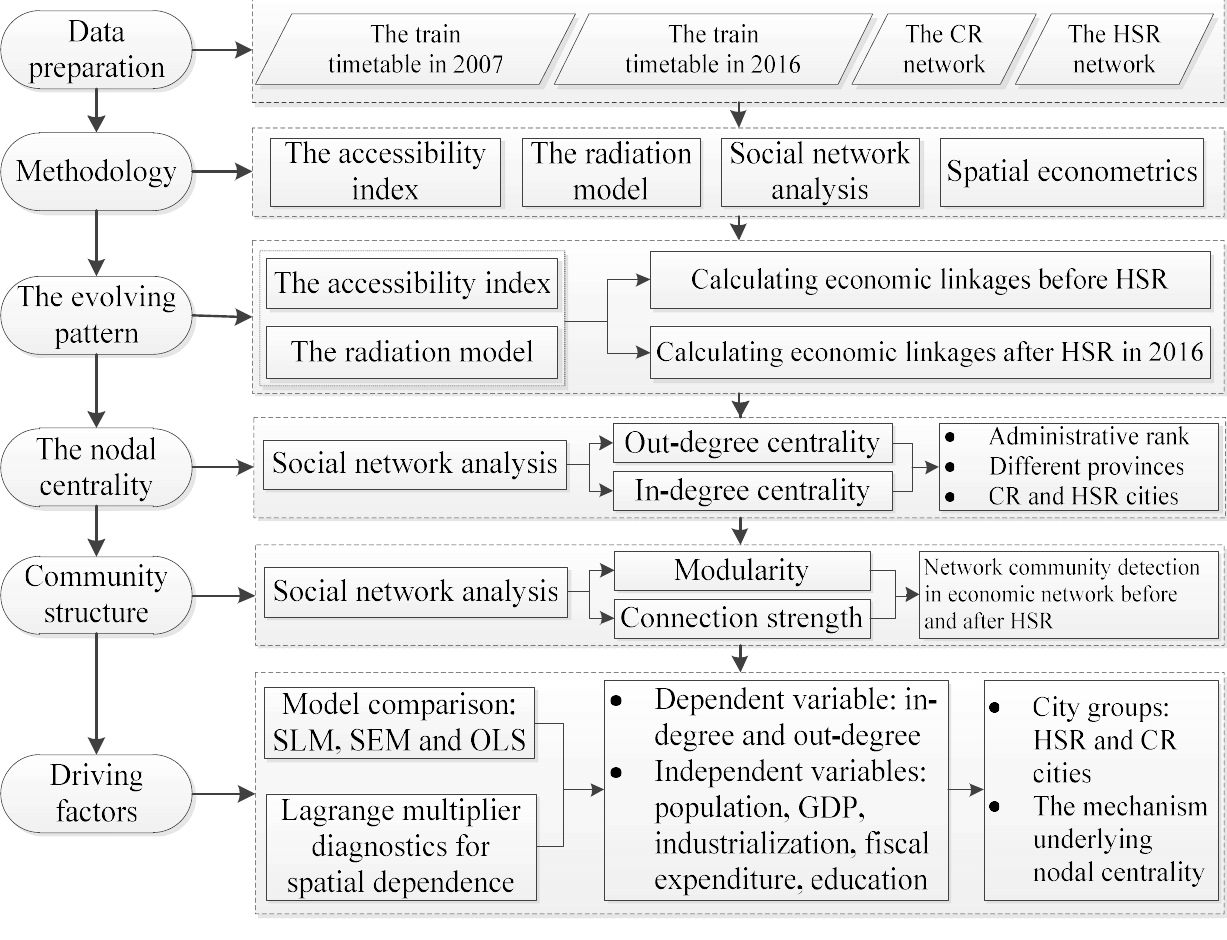
Figure 2. The work flow of this study.